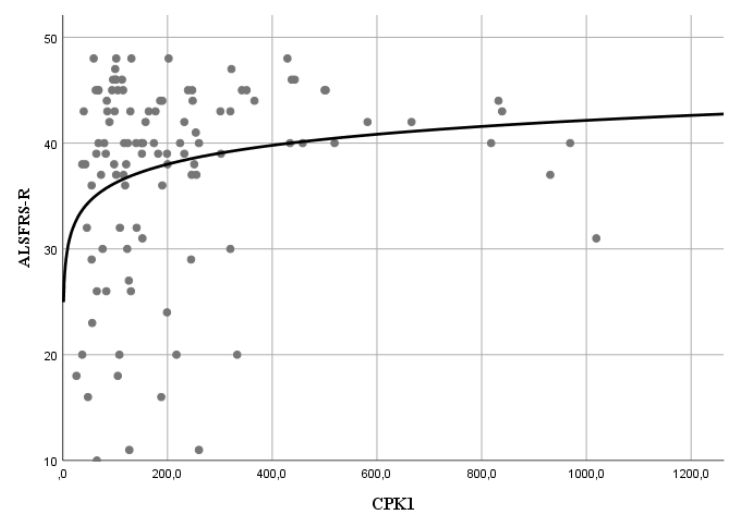
Table 2. CK and ALSFRS-R progression over time . Figure 2. Correlation between ALSFRS-R score and CK levels at T1. Figure 2. Correlation between ALSFRS-R score and CK levels at T1.